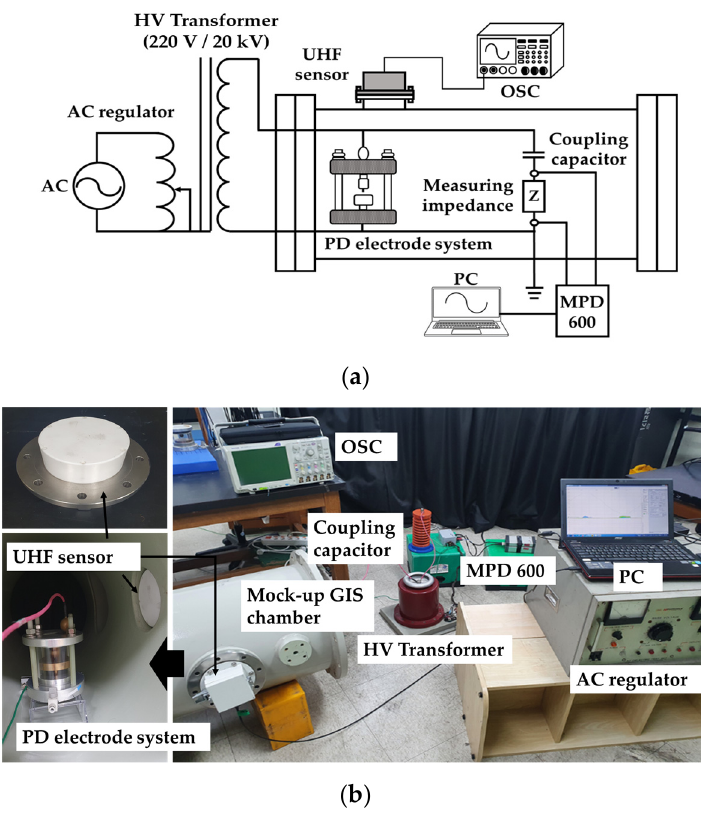
Figure 3. Experimental configuration: ( a ) a circuit and ( b ) a photograph.